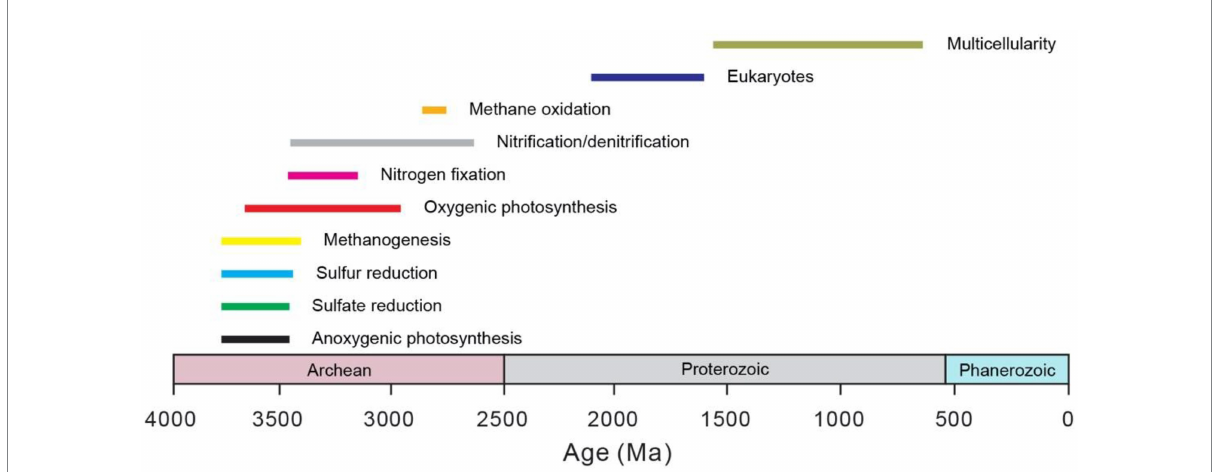
FIGURE 1 Origin of major microbial metabolisms and groups through time. The bars represent the uncertainty in the estimation. The data are mainly from Moore et al. (2017). Note that the microbes before the rise of eukaryotes all belong to prokaryotes. The age for the origin of eukaryotes comes from Knoll et al. (2006). The age for the origin of multicellular eukaryotes comes from Zhu et al. (2016) and the references